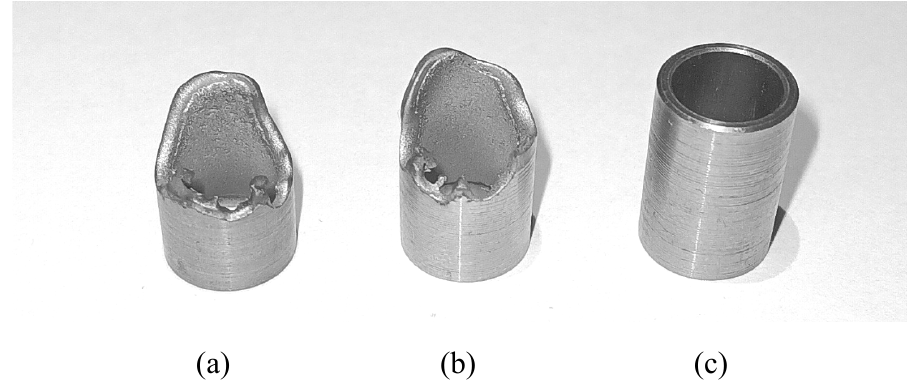
Figure 2. Comparison of titanium cathodes used as fuel in the HERVAT thruster head. The left cathode ( a ) was operated for 1.27 × 10 7 pulses while the middle cathode ( b ) was operated for 1.01 × 10 7 pulses. The cathode on the right ( c ) is unused and has an initial length of 15mm and a diameter of 10mm ×